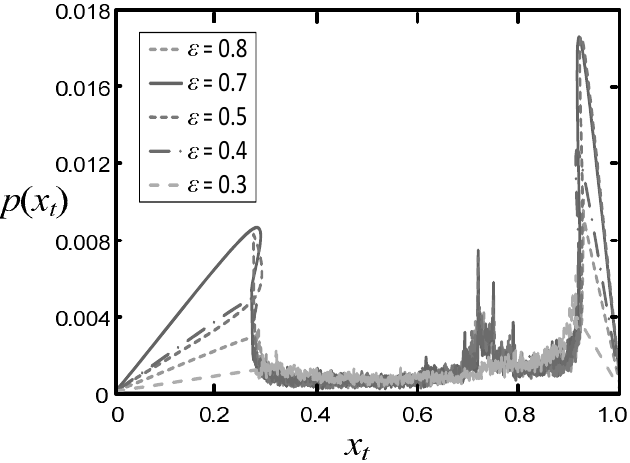
Figure 3. Simulation algorithm for original CML.